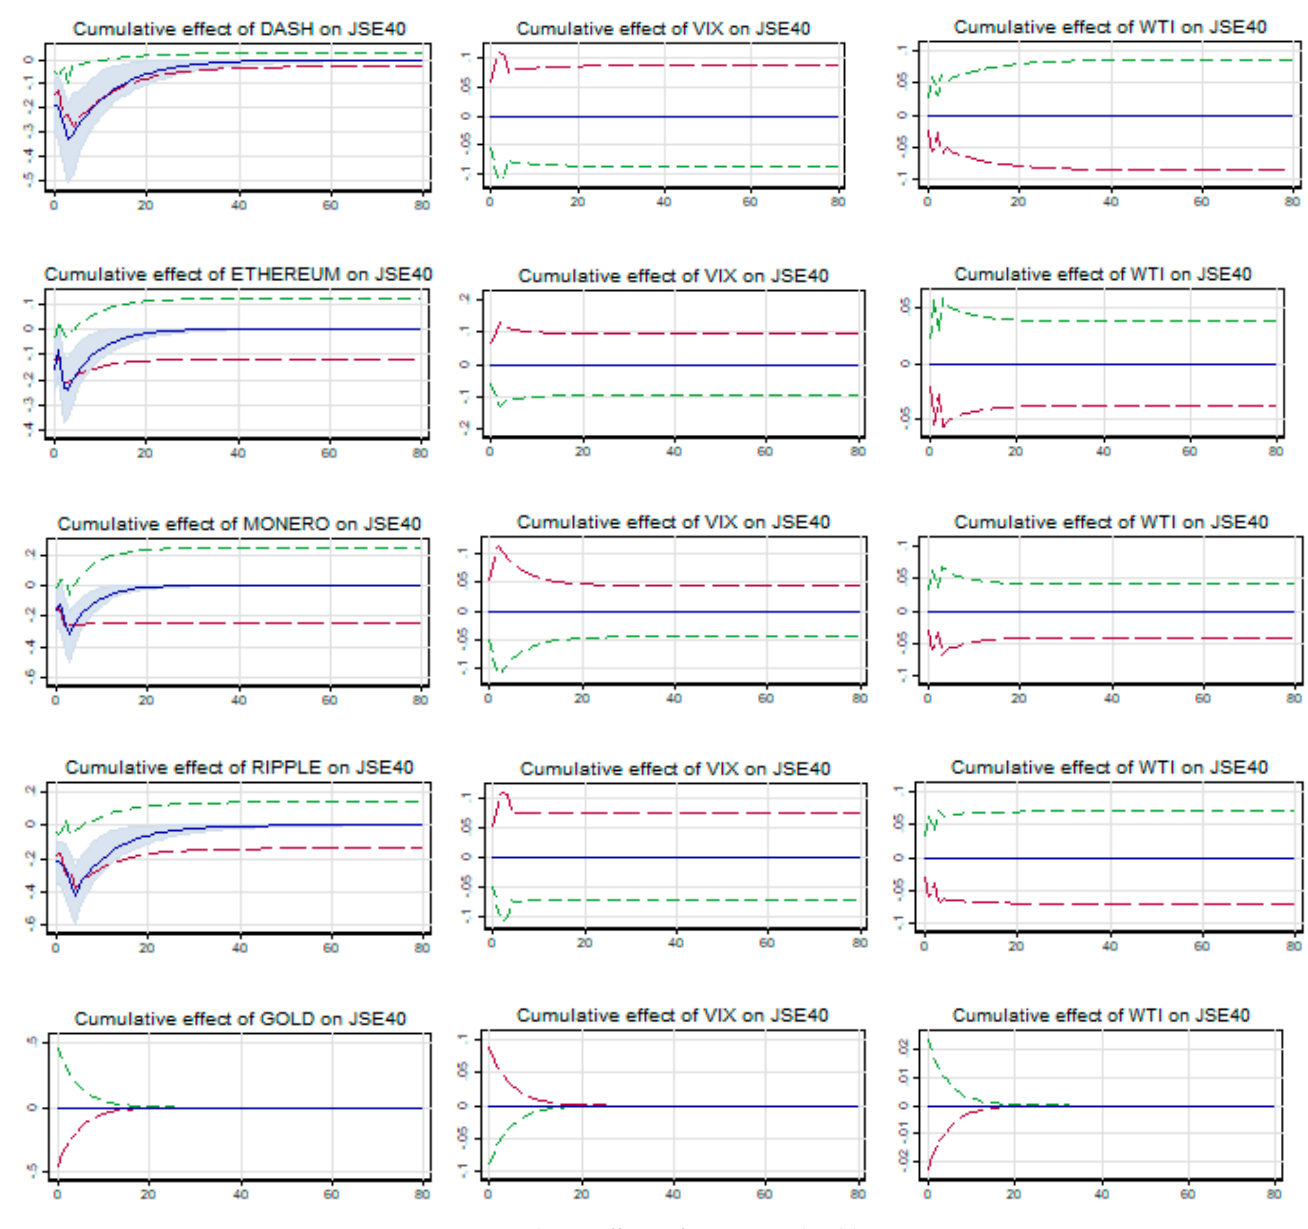
Figure 8. Cumulative effects of cryptos and gold on JSE40.